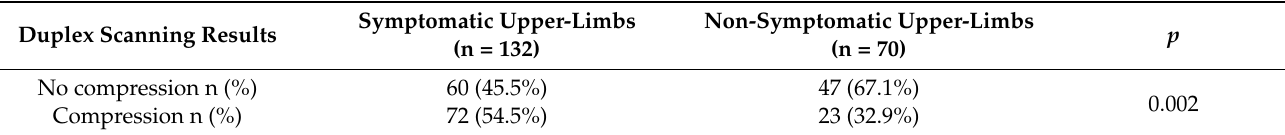
Table 4. Vessels assessment by duplex ultrasound scanning depending on the symptomatic or non-symptomatic upper-limb. Duplex Scanning